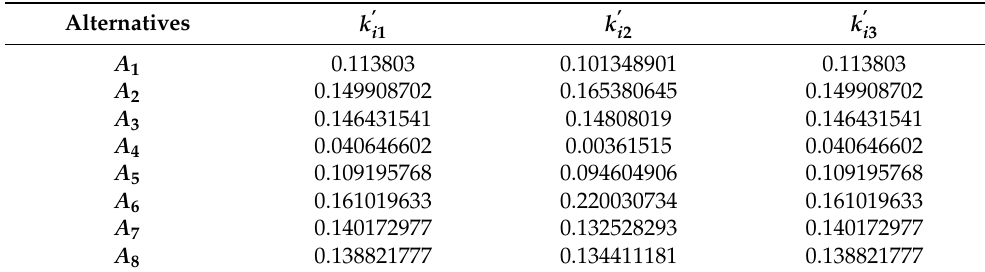
Table 10. Normalized evaluation score blueprints of